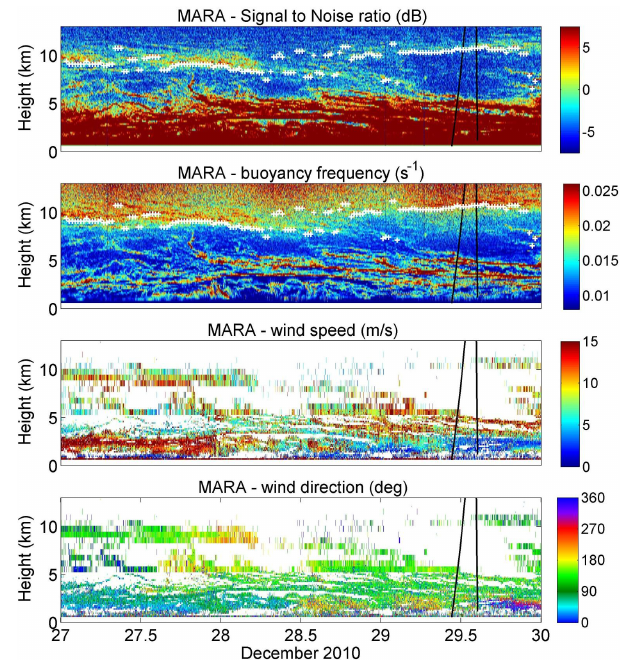
Fig. 1. MARA radar observations of signal to noise ratio (dB), buoyancy frequency (s − 1 ), wind speed (m/s) and wind direction (deg) from 27 December 2010 to 29 December 2010. Nearly ver- tical black lines represent the time of ascent and descent of the